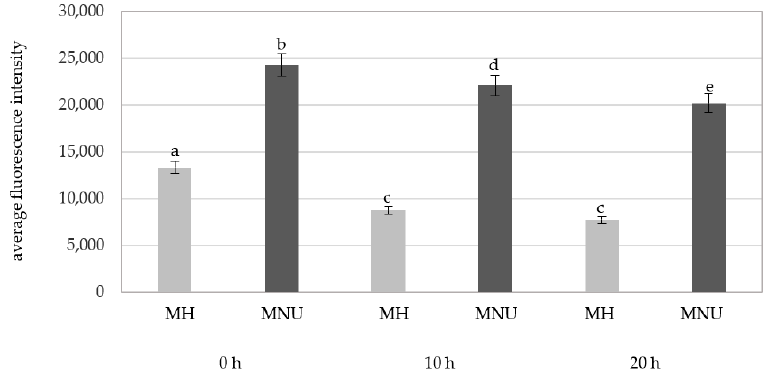
Figure 8. A comparison of the average fluorescence intensity of Alexa 488 that was used to detect 5mC in the B. distachyon parental nuclei with micronuclei in MH- and MNU-treated cells at different posttreatments times. Fluorescence of Alexa 488 was measured in relative units. ANOVA followed by Tukey HSD test, p < 0.05; mean ± SD, statistically significant differences are indicated by different letters.